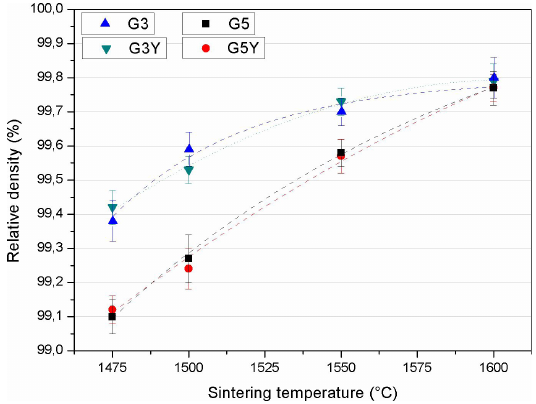
Figure 1. Relative density of zirconia samples sintered at different